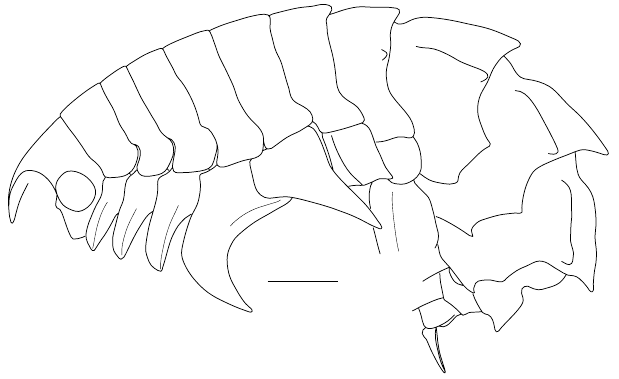
Figure 19. Epimeria cornigera , paratype, adult male, northern North Sea, NHMUK 2015.3269, lateral habitus; scale 1